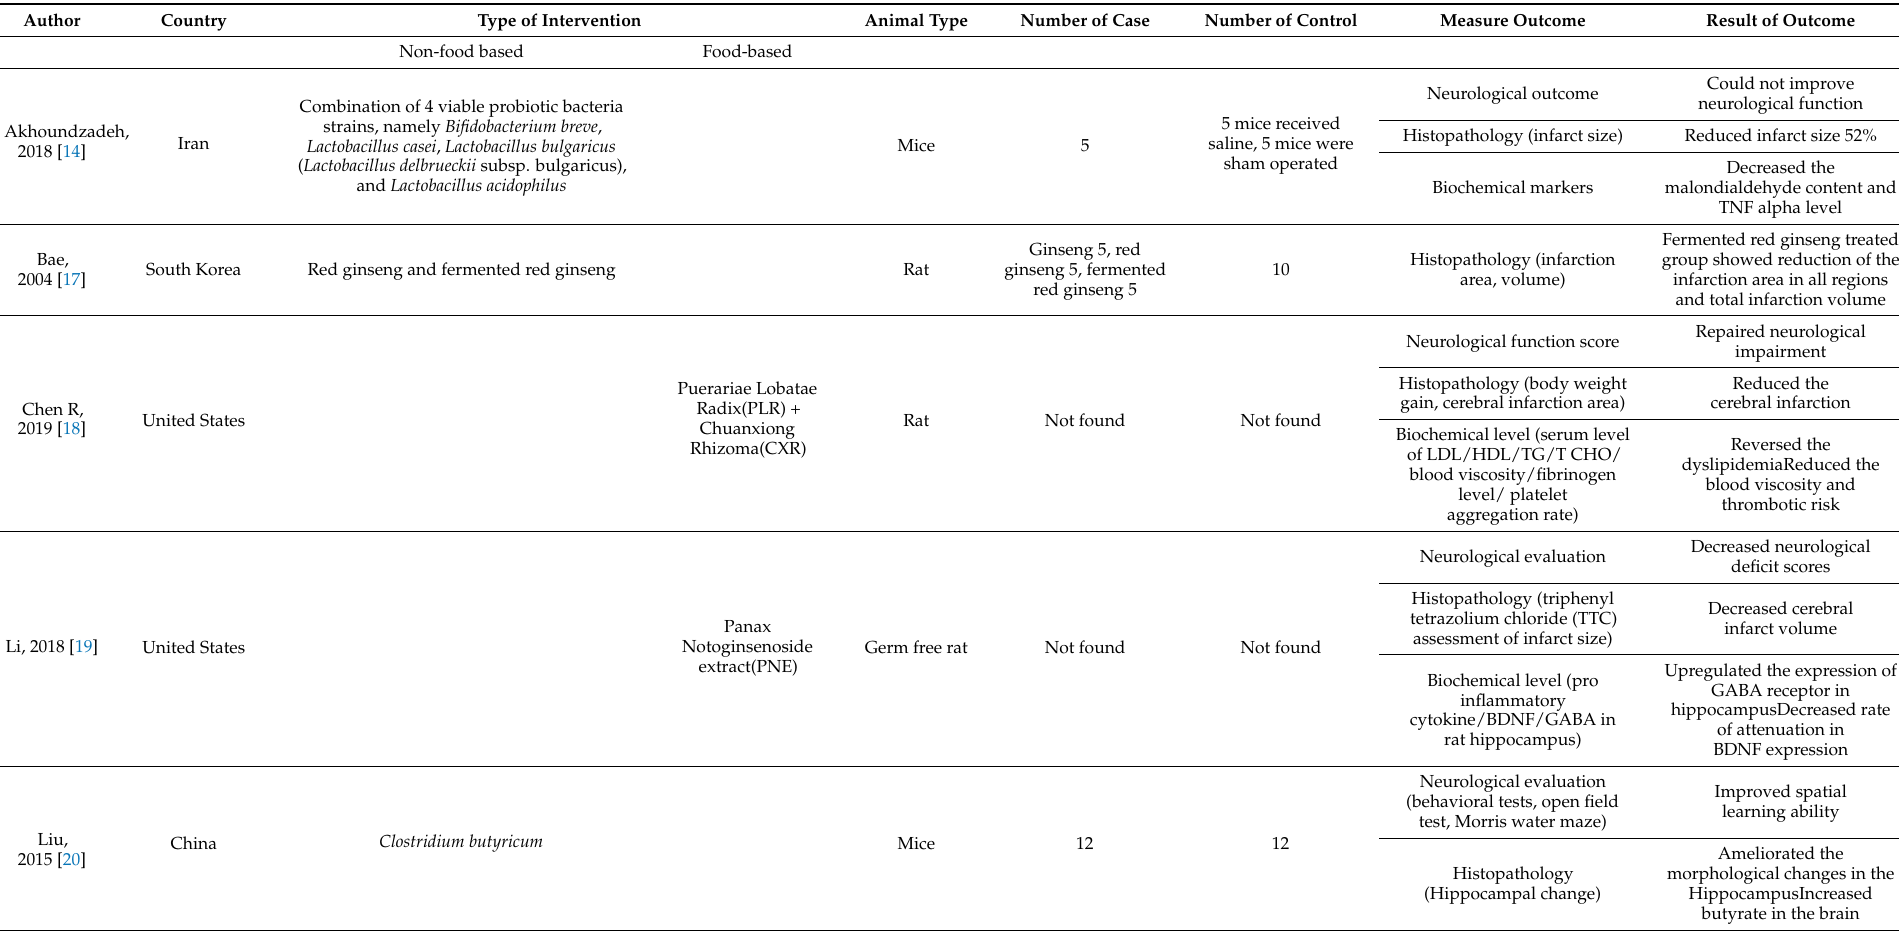
Table 1. The characteristics of the articles in which probiotics are the intervention in stroke animal